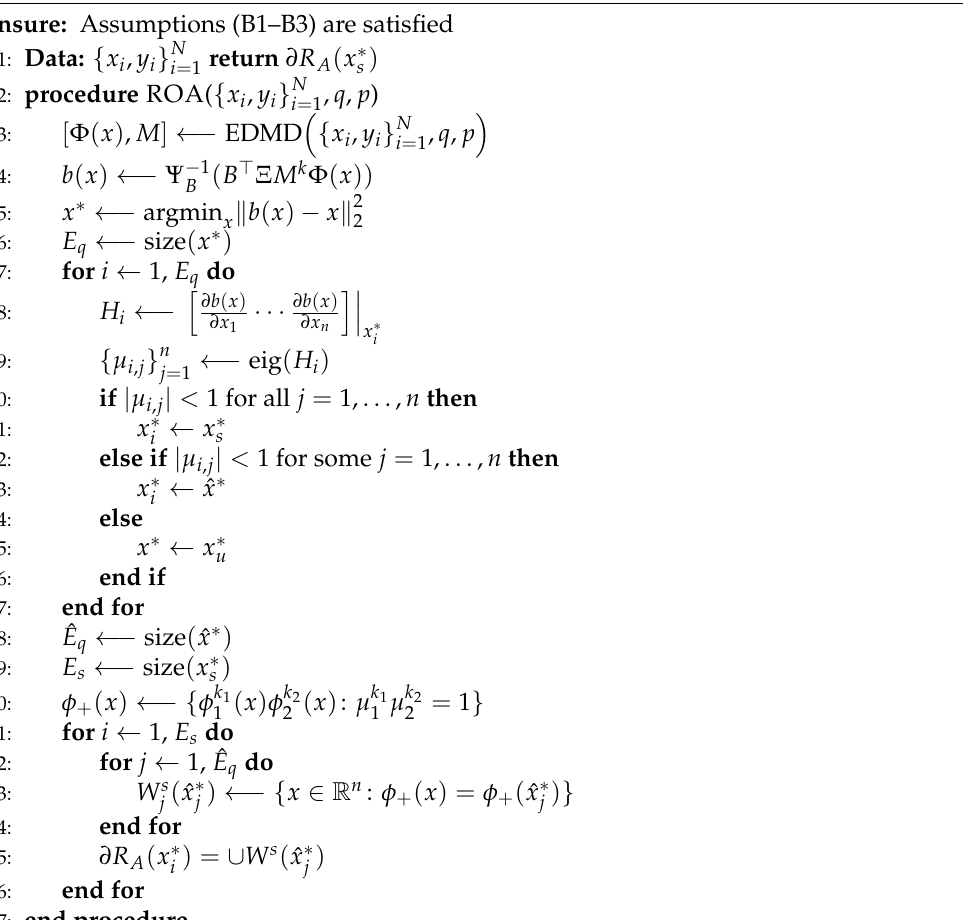
Algorithm 1 ROA with data-driven discrete Koopman